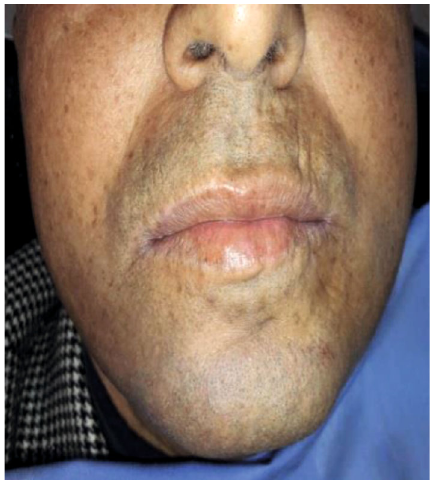
Figure 1: Front view. Slight facial